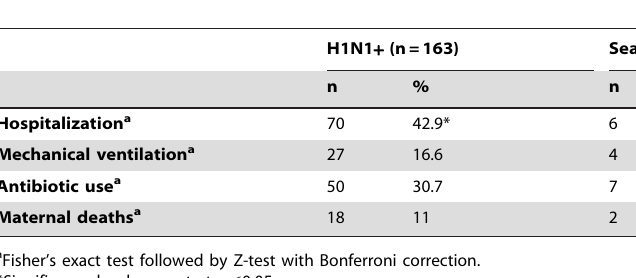
Table 2. Pregnancy outcomes in H1N1 confirmed cases and non-H1N1 influenza cases in south Brazil.